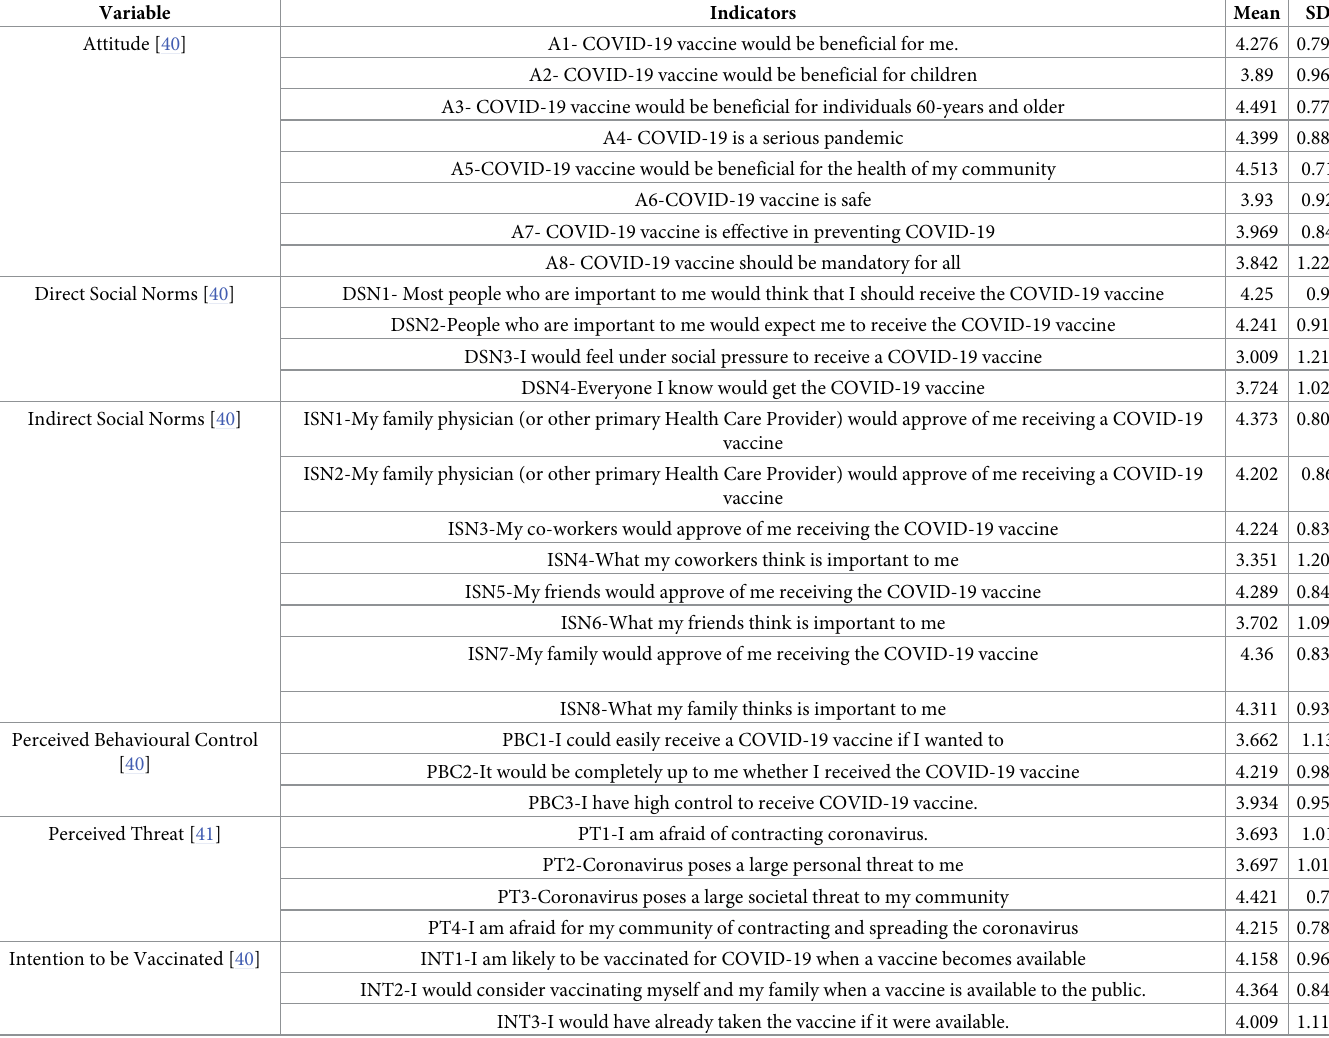
Table 2. Research variables, average item mean for both